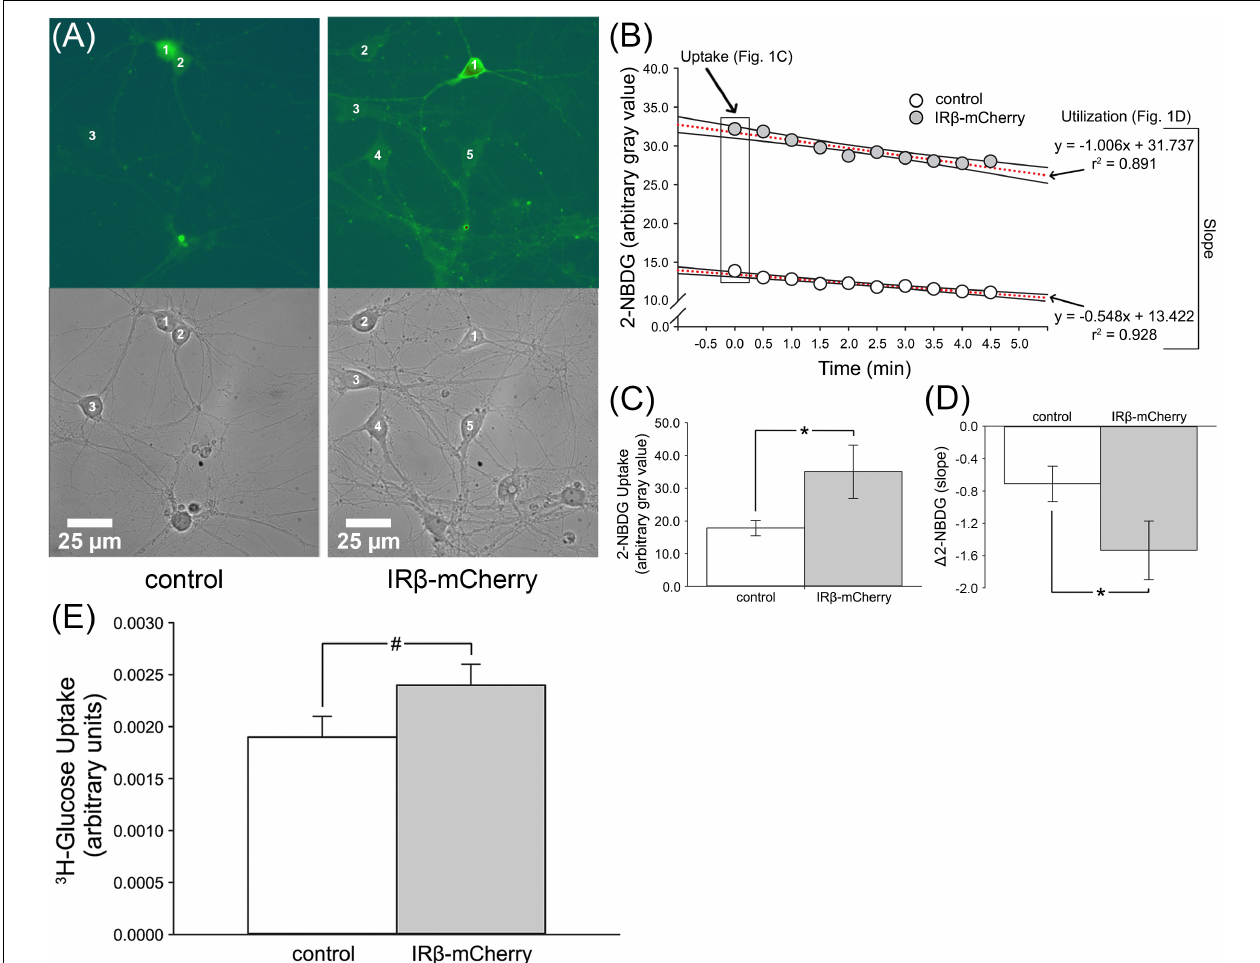
FIGURE 1 | 2-NBDG imaging and relative levels of 3 H-glucose uptake in mixed, primary hippocampal neurons with or without expression of IR β . (A) Representative phase and 2-NBDG fluorescent photomicrographs obtained from hippocampal cultures. Numbers 1–5 indicate distinct neurons. (B) Data obtained from a representative control and IR β -expressing neuron during 2-NBDG imaging. Boxed data at time point 0.0 indicate initial gray values used for 2-NBDG uptake analysis. Dashed red lines indicate linear regressions used for (cid:49) 2-NBDG calculation (slope). (C) Quantification of background-subtracted 2-NBDG uptake in hippocampal neurons with or without IR β expression. Significant elevation in 2-NBDG uptake was observed in IR β -expressing neurons ( n = 50 dishes) compared to controls ( n = 42 dishes) (Student’s t -test, p = 0.046). (D) Quantification of background-subtracted change in 2-NBDG fluorescence ( (cid:49) 2-NBDG) used to infer indirect rates of glucose utilization. A significant increase in the rate of 2-NBDG utilization was observed in IR β -expressing neurons ( n = 25) compared to controls ( n = 21) (Student’s t -test, p = 0.044). (E) 3 H-glucose uptake measures were derived from a total of 3 independent cultures ( n = 3 dams, 21 dishes per group). A strong trend for an elevation in radiolabeled glucose uptake was observed in the IR β -expressing dishes compared to controls (Student’s t -test, p = 0.120). All data represent means ± SEM. Asterisks (*) indicate significance at p < 0.05. Hash (#) indicates trend at p <